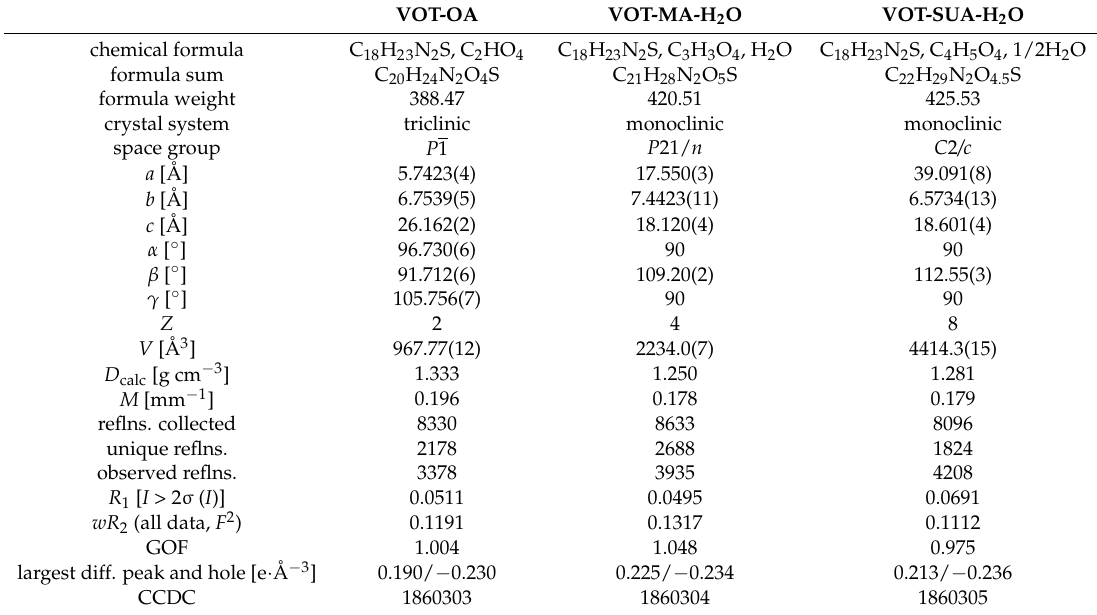
Table 1. Crystallographic Parameters of Vortioxetine and its dihydroxybenzoic acid salts.